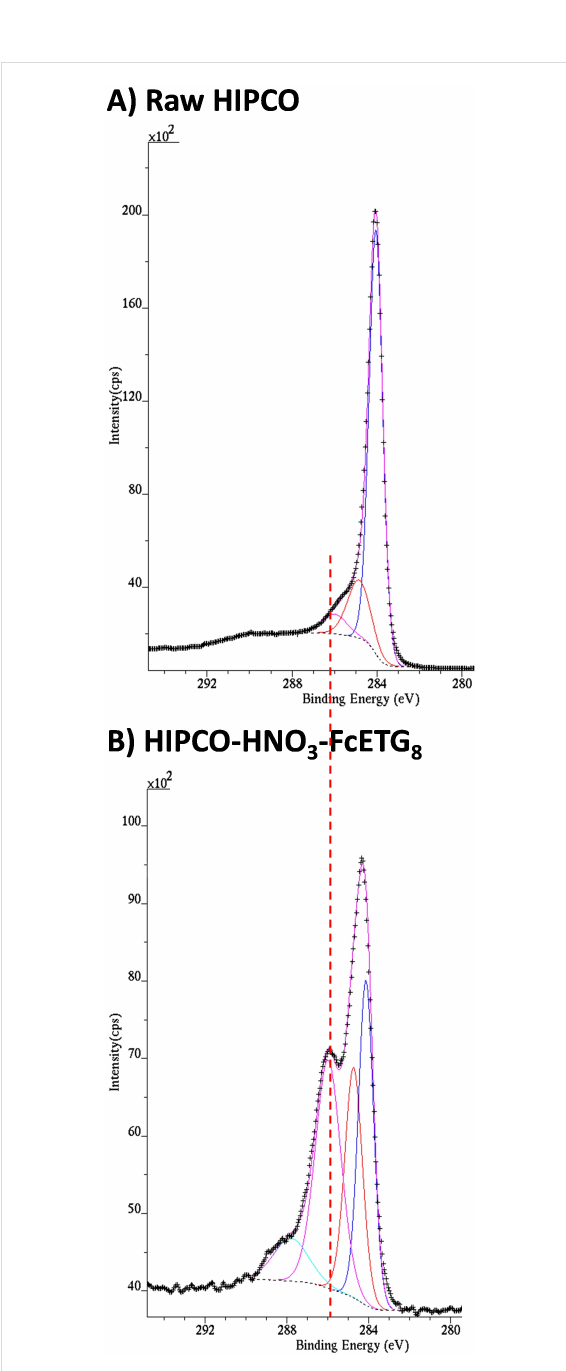
Figure 5: Detailed C 1s spectra of A) raw HIPCO and B) HIPCO- HNO 3 -FcETG 8 . The binding energies of the Fe 2p components were always at 720.4 eV and 706.5 eV for the 2p 1/2 and 2p 3/2 components, respectively, which are typical values for the Fe(II) oxidation state in ferrocene compounds